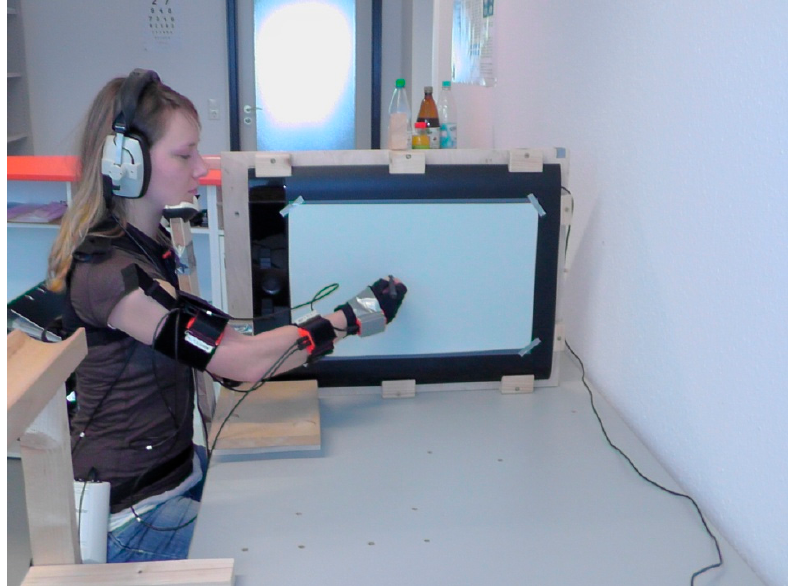
Figure 2. The experimental arrangement for the measurements in the yz -plane.